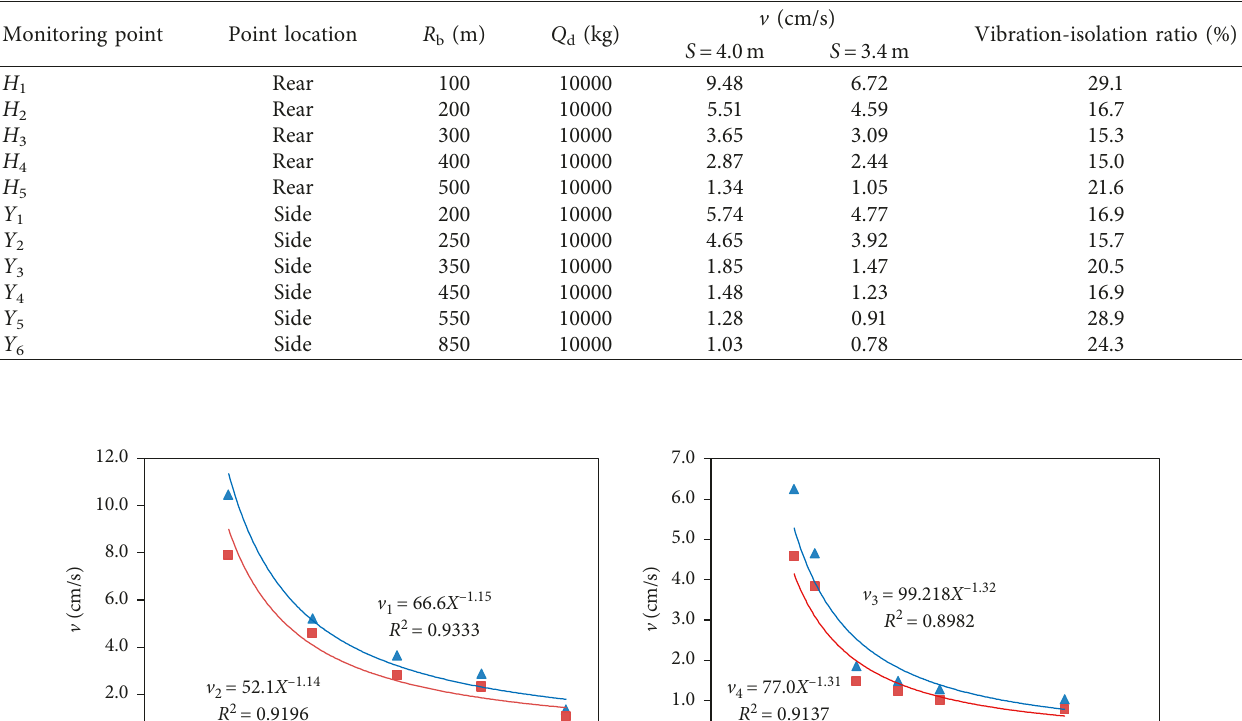
Table 4: Monitoring data and vibration-isolation effect during presplit blasting.